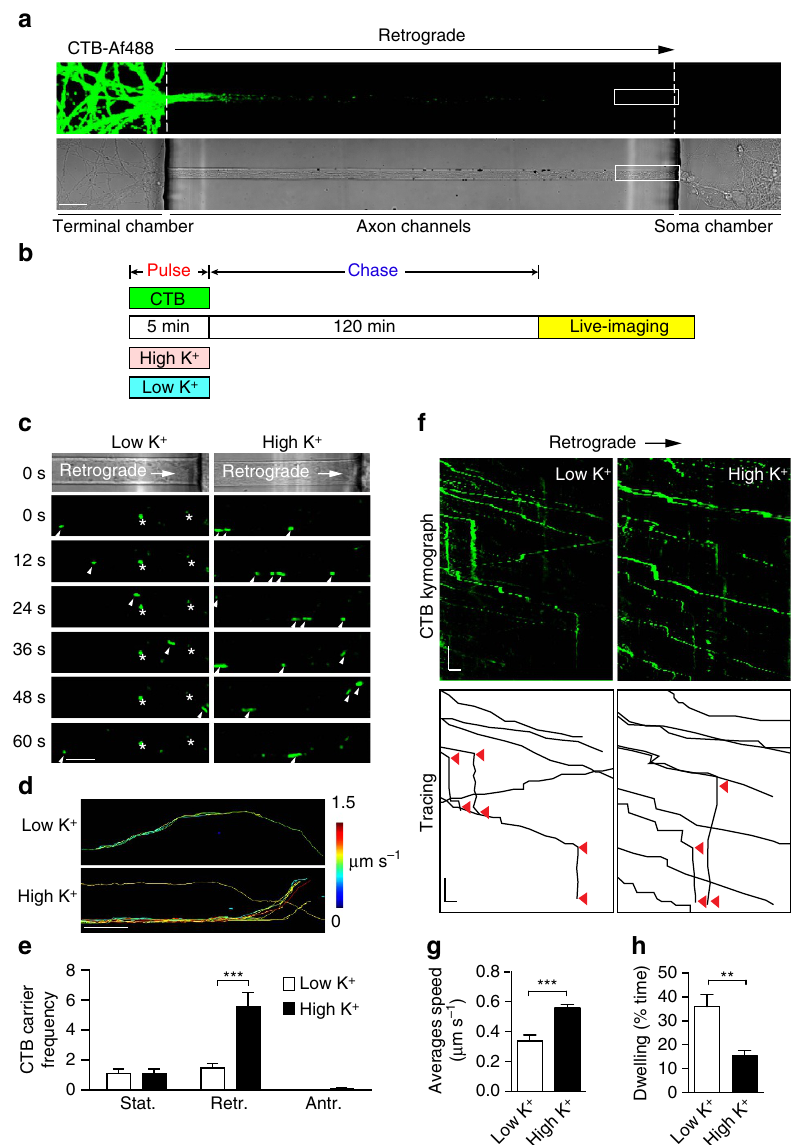
Figure 2 | The flux of retrograde CTB carriers is activity-dependent in cultured rat hippocampal neurons. ( a ) CTB-Af488 labelling was performed in nerve terminals of hippocampal neurons cultured in microfluidic devices. CTB retrograde trafficking was captured in the observation window along the